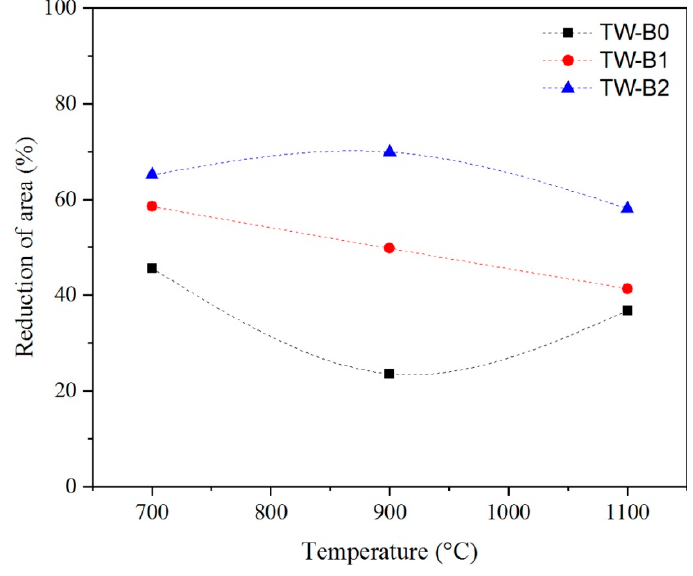
Figure 12. Hot ductility behavior of studied TWIP steels as a function of temperature.